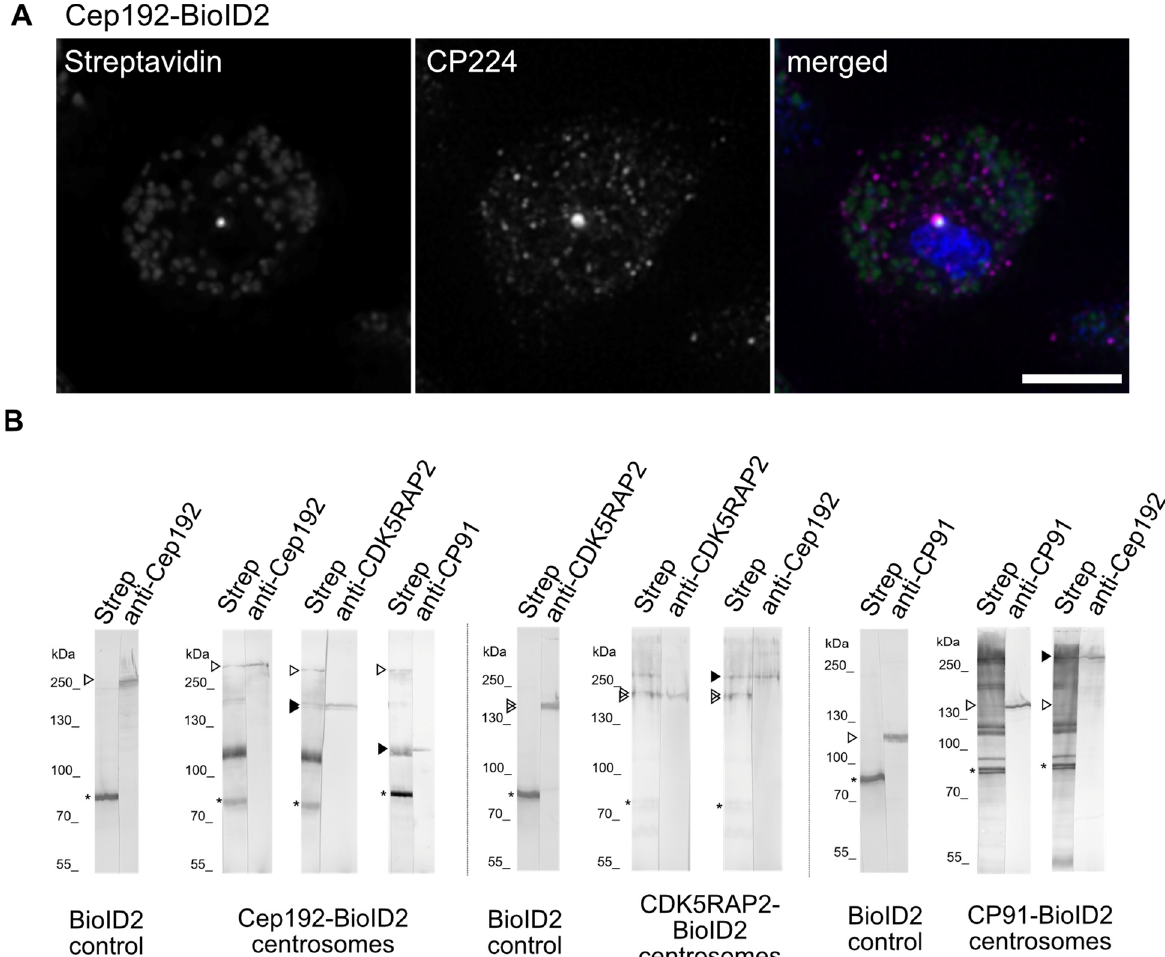
Figure 4. Centrosomal interactions of C-terminally biotinylase-tagged Cep192, CDK5RAP2, and CP91 in the BioID2 assay. ( A ) Immunofluorescence microscopy of methanol-fixed Cep192-BioID2 cells after treatment with 2 µM Biotin stained with anti-CP224/anti-mouse-AlexaFluor-568 and streptavidin-AlexaFluor-488, Bar = 5 µm. ( B ) BioID2 Western blot analysis of centrosomal fractions of Cep192-BioID2, CDK5RAP2-BioID2, and CP91-BioID2 cells. The nitrocellulose membrane was cut into lanes, whereby each lane was cut into equal halves. After blotting, half-lanes were stained with the indicated antibodies and streptavidin, respectively. ‘Strep’ refers to the individual biotinylation pattern detected by alkaline phosphatase coupled Streptavidin. Open arrowheads represent the fusion proteins and the respective endogenous proteins in the control cells, the size difference is due to the 27kDa BioID2 tag. Filled arrow heads highlight potential interactors found by co-staining with their respective antibody. As secondary antibody anti-rabbit-alkaline-phosphatase was used. Bands were visualized using NBT/BCIP color detection. Controls expressed FLAG-BioID2 alone and were treated the same way. Stars indicate endogenously biotinylated proteins always visible in streptavidin staining.